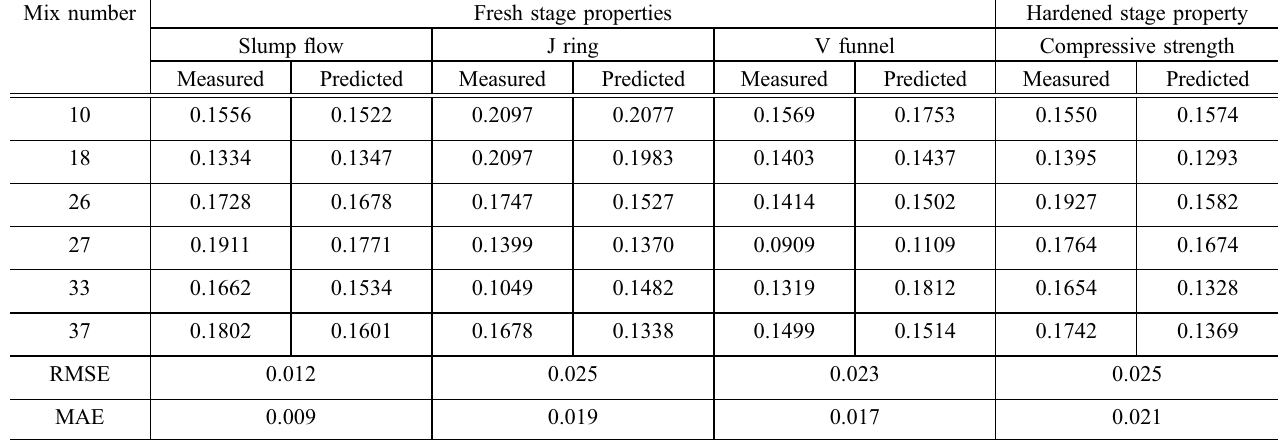
Table 5 Comparison of measured and predicted normalized values of familiar mixes.